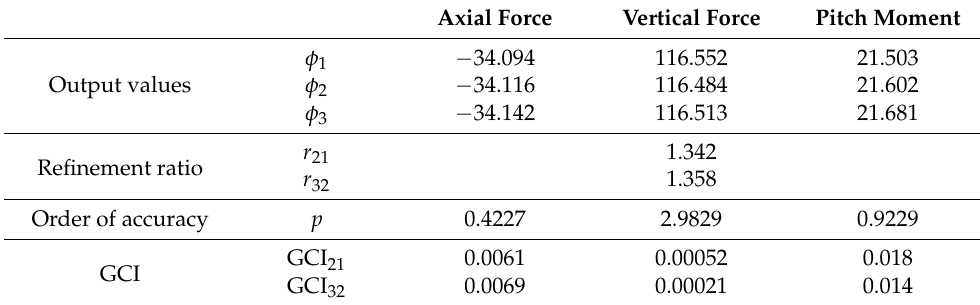
Table 2. Grid convergence